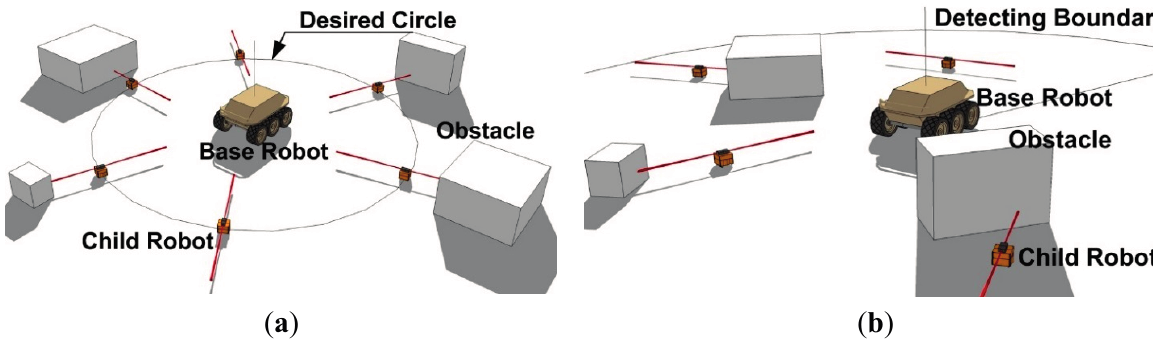
Figure 3. Two CESS control strategies with respect to the positioning systems. ( a ) CESS using the vector field based control law with vision based positioning system; ( b ) CESS using the behavior based control algorithm with the UWB-based positioning